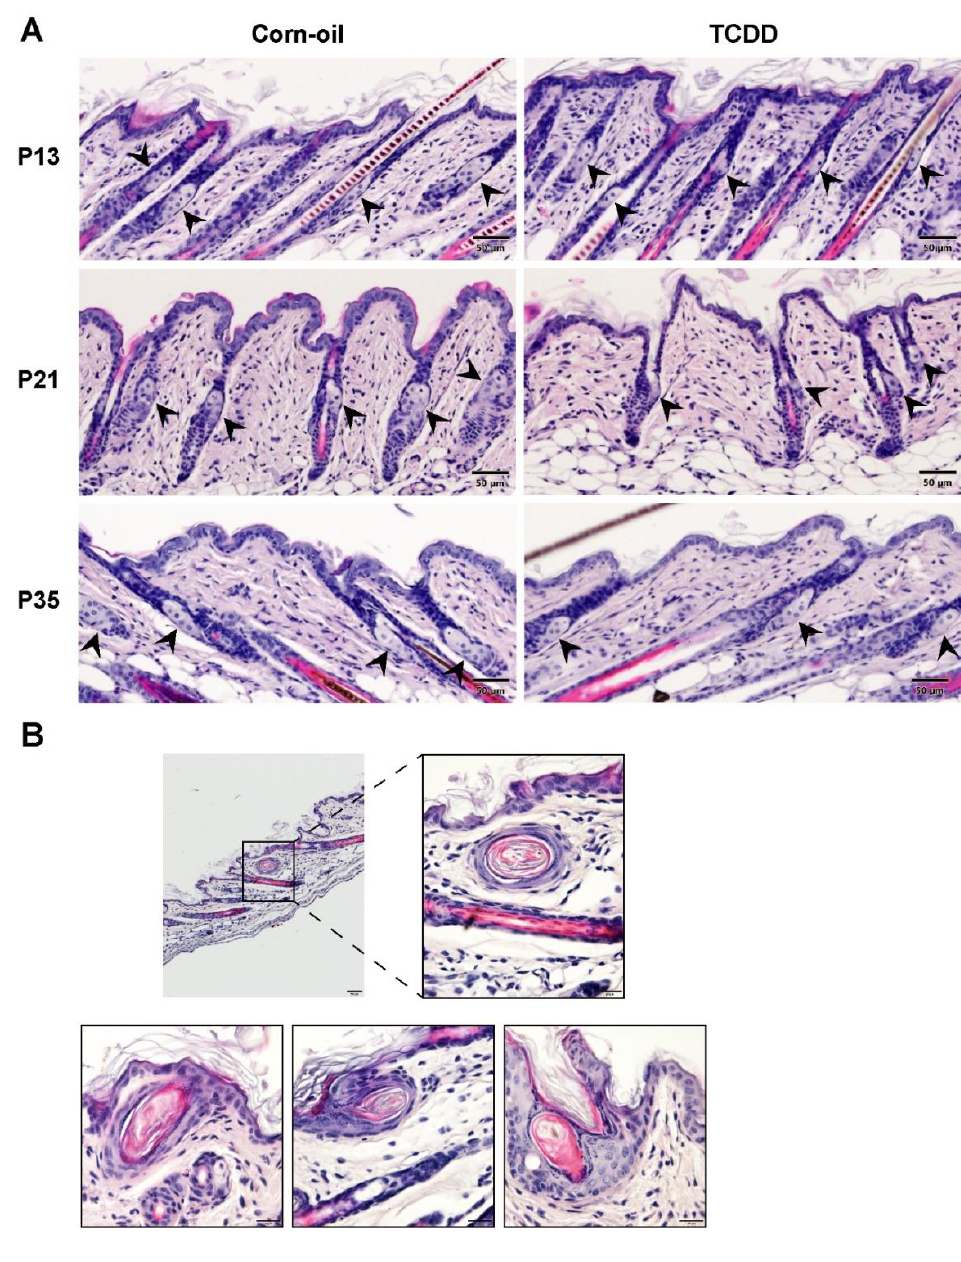
Figure 5. Sebaceous hypoplasia in TCDD-exposed mice. Time-mated mice were treated by gavage with either corn-oil or TCDD (5 µ g/kg bw) and pups were analyzed for effects on the pilosebaceous unit. ( A ) Representative images of H&E staining of corn-oil- and TCDD-treated skin at P13, P21, and P35. Scalebar = 50 µm. Arrowheads point towards sebaceous glands. ( B ) Sections of TCDD- treated mice skin stained with H&E at P21 showing the development of keratinous cysts ( n = 4). Scalebar = 50 µm. Magnified images in boxes, scalebar = 20 µm. Abbreviations: TCDD, 2,3,7,8-tetrachlorodibenzo- p -dioxin; bw, body weight; H&E, hematoxylin and eosin; P, postnatal day.